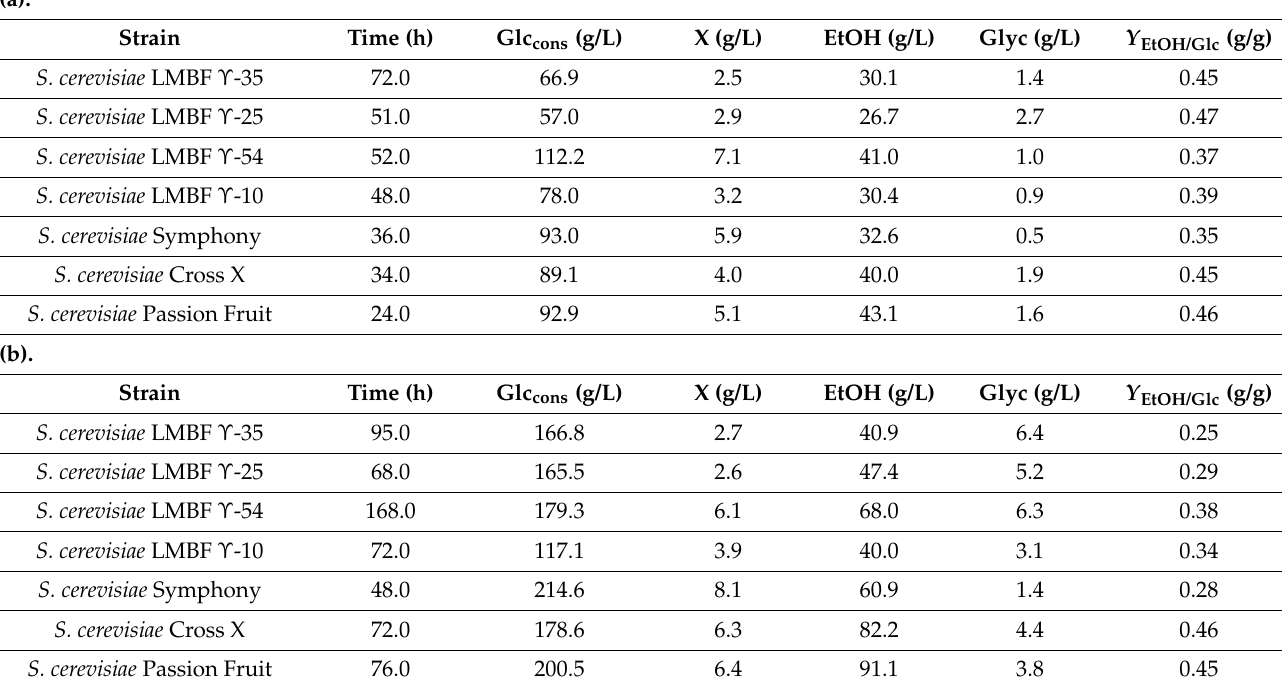
Table 1. Experimental results originated from kinetics of S. cerevisiae wild strains (LMBF Y-10, Y-25, Y-35 Y-54) and commercial strains (Symphony, Passion Fruit, Cross X) growing in shake-flask glucose- based synthetic media at initial glucose concentration ≈ 100 g/L (a) and ≈ 200 g/L (b) when the maximum concentration of ethanol (EtOH max ) was achieved. Representations of dry biomass (X, g/L), glucose consumed (Glc cons , g/L), ethanol produced (EtOH, g/L) and ethanol conversion yield per sugar consumed ( Y EtOH/Glc , g/g). Each experimental point is the mean value of 2 independent measurements (SE for most experimental points ≤